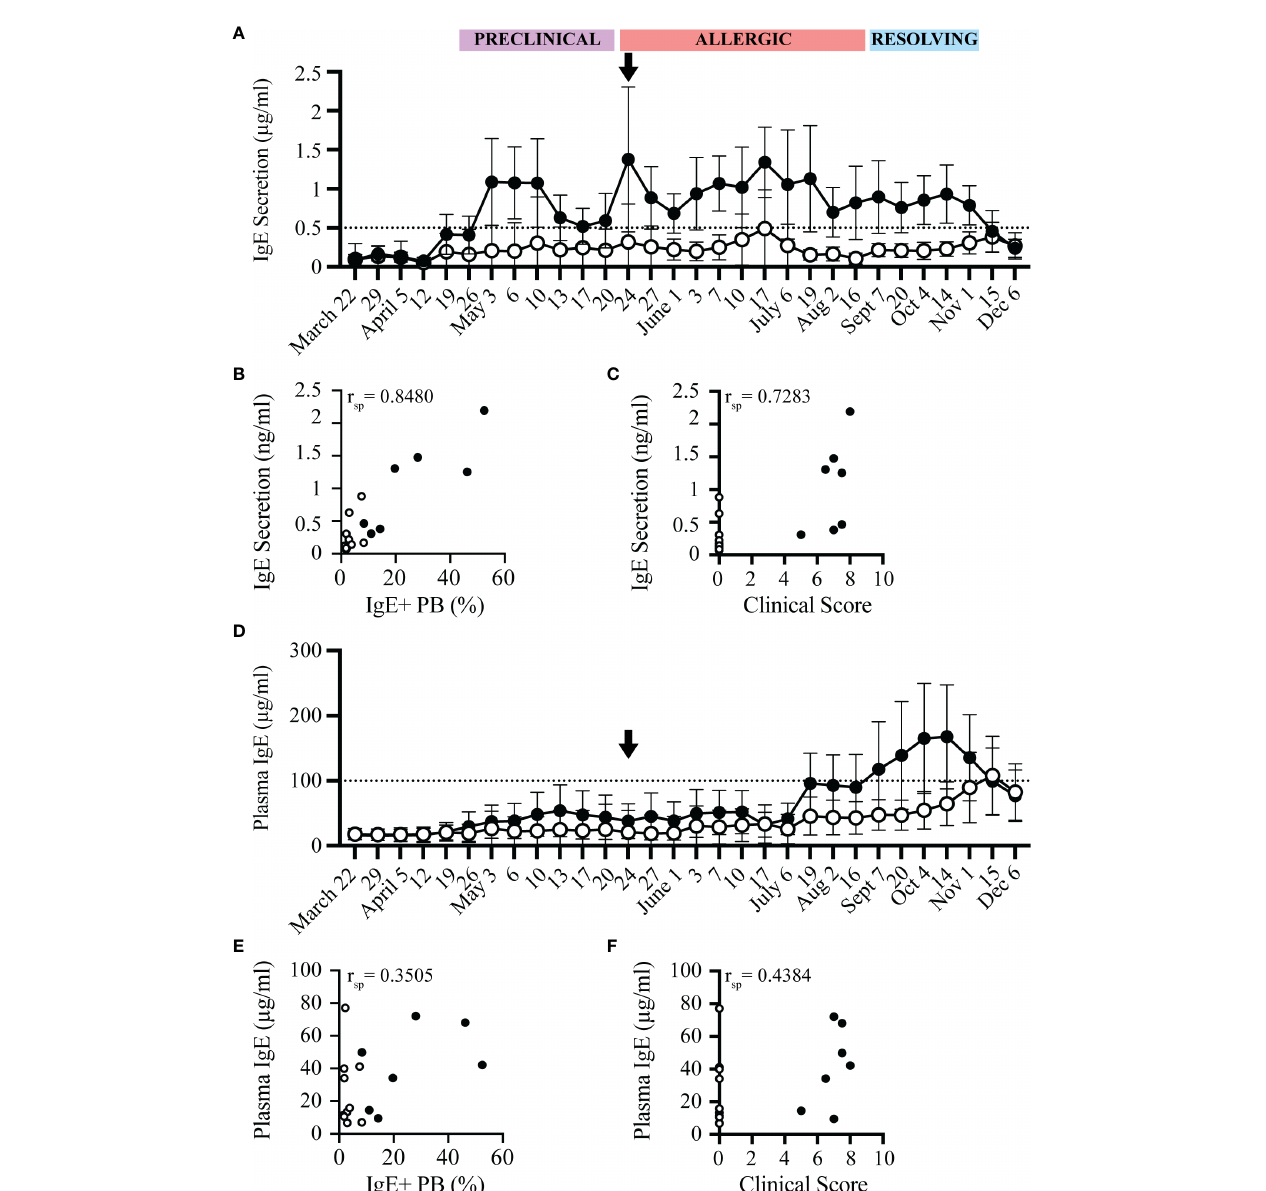
FIGURE 5 IgE secretion from PBL, but not plasma IgE, increases before onset of clinical allergy. PBL and cell-depleted plasma samples were collected from allergic (n=7, black circles) and healthy (n=10, open circles) horses every 3-14 days for one year. The concentration of secreted IgE by PBL was evaluated in cell culture supernatants after 72 hours of in vitro culture. IgE concentrations were measured by a bead-based IgE assay. (A) Secreted IgE was compared at each timepoint. The dotted line denotes the threshold where allergic horses had ≥ 0.5 µg/ml secreted IgE. Black arrow shows the fi rst day allergic horses had clinical allergy scores above the clinical threshold (May 24). (B) Spearman rank correlation of the frequency of IgE+ plasmablasts (out of CD23+) and the concentration of secreted IgE from PBL (µg/ml). (C) Spearman rank correlation of clinical score and the concentration of secreted IgE from PBL (µg/ ml). (D) Total IgE (µg/ml) in plasma was compared at each timepoint. The dotted line denotes the threshold where allergic horses had ≥ 100 µg/ml plasma IgE. (E) Spearman rank correlation of the frequency of IgE+ plasmablasts (out of CD23+) and the concentration of plasma IgE (µg/ml). (F) Spearman rank correlation of clinical score and the concentration of plasma IgE (µg/ml). All correlations were calculated with samples collected on July 6, during the Chronic